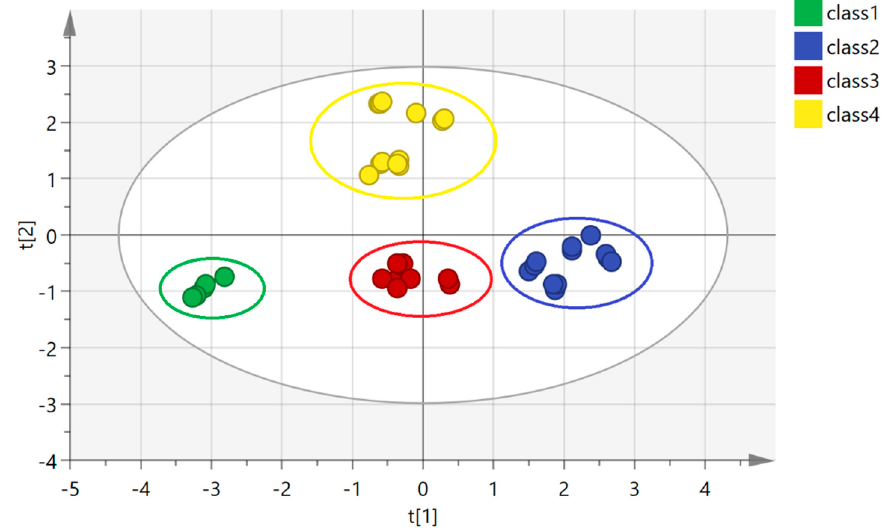
Figure 2. PCA score scatter plot for different classes of CDs.